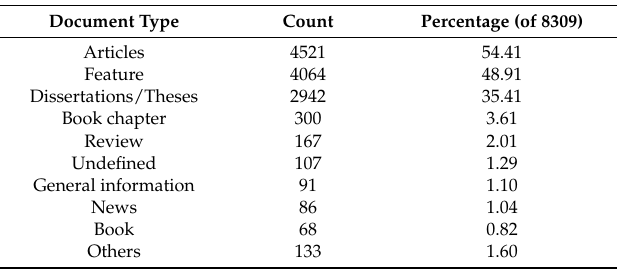
Table 12. Document types for SLW publications in